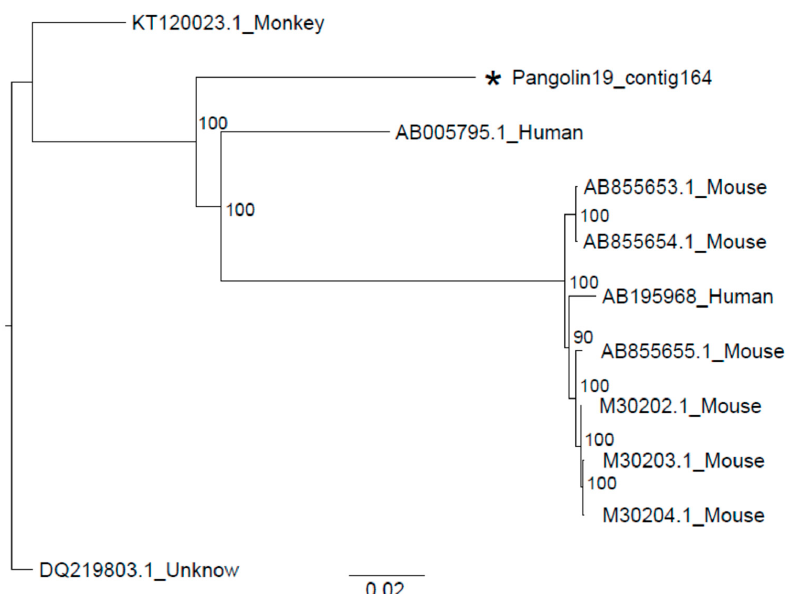
Figure 3. The phylogenetic tree of the Sendai virus from Malayan pangolin and other hosts. The analysis was inferred using the Maximum Likelihood method based on iqtree [24]. Branch bootstrap values are shown and were based on 1000 replicates. The black star indicates a contig of the Sendai virus from M. javanica in 2019.